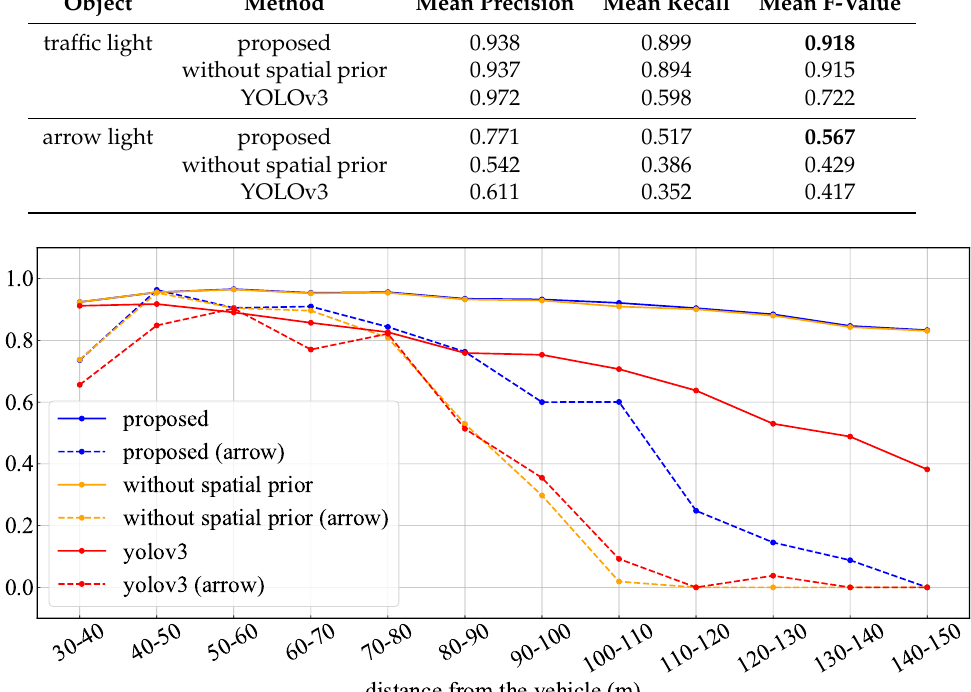
Figure 13. F values for whole data: with or without the prior